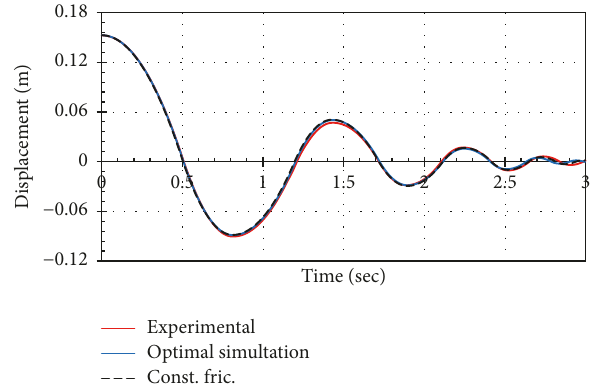
Figure 14: Simulation time history of displacement for the friction functionofmeasuringdisplacementandindividualbestfitandover- all best fitting function (WD40 sprayed with initial displacement of 106.76 mm).